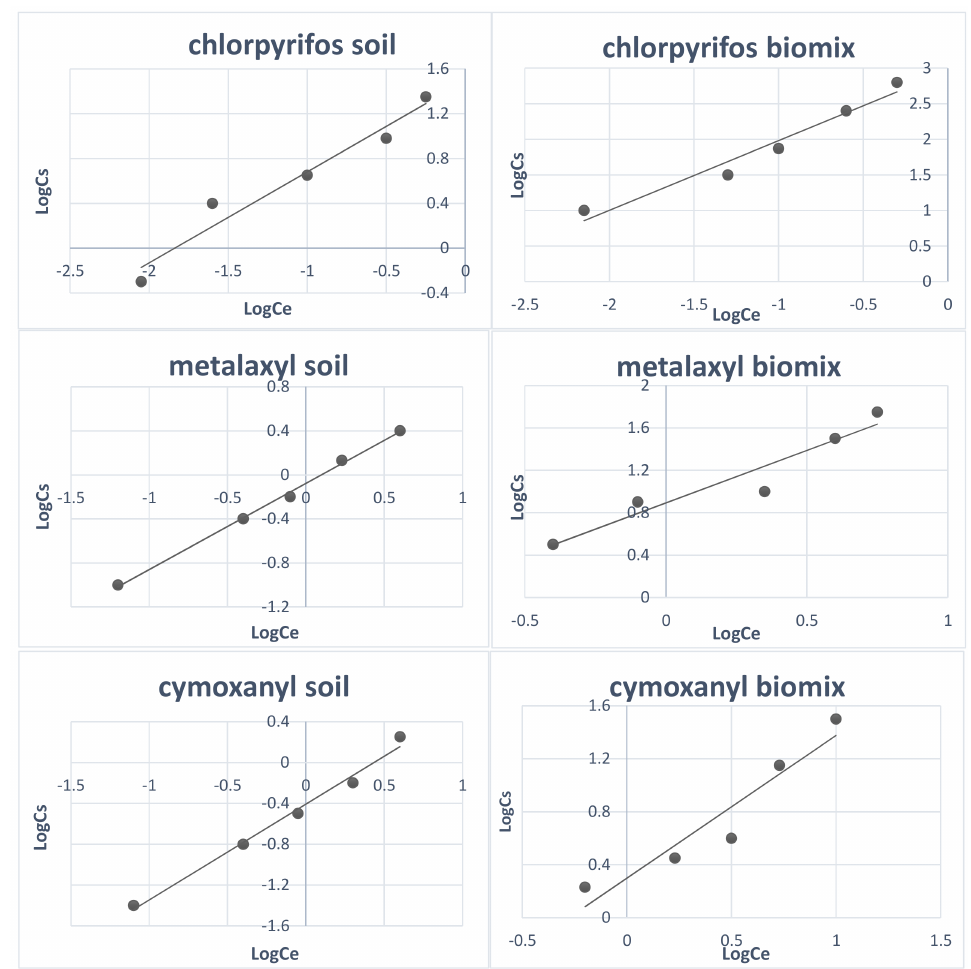
Figure 1. Adsorption isotherms for the three pesticides derived from the batch equilibrium experiment (data are the means of three replicates; standard error even < 1.8% in soil samples and < 3.1% in biomix samples). R 2 values always significant at p < 0.001 level. Table 3. Adsorption parameters for the three pesticides in soil and biomix (data are the mean of